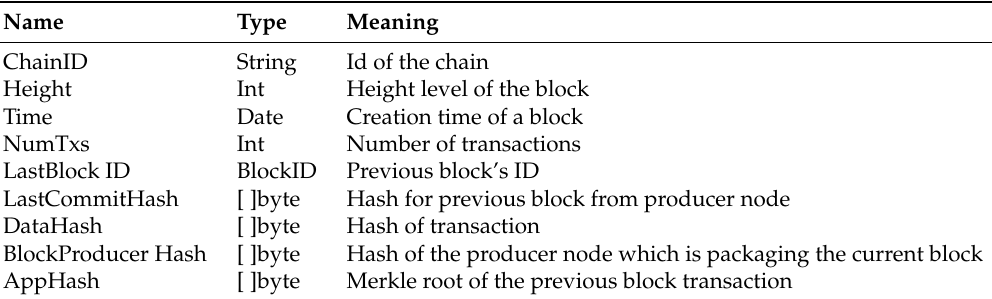
Table 1. Structure of block